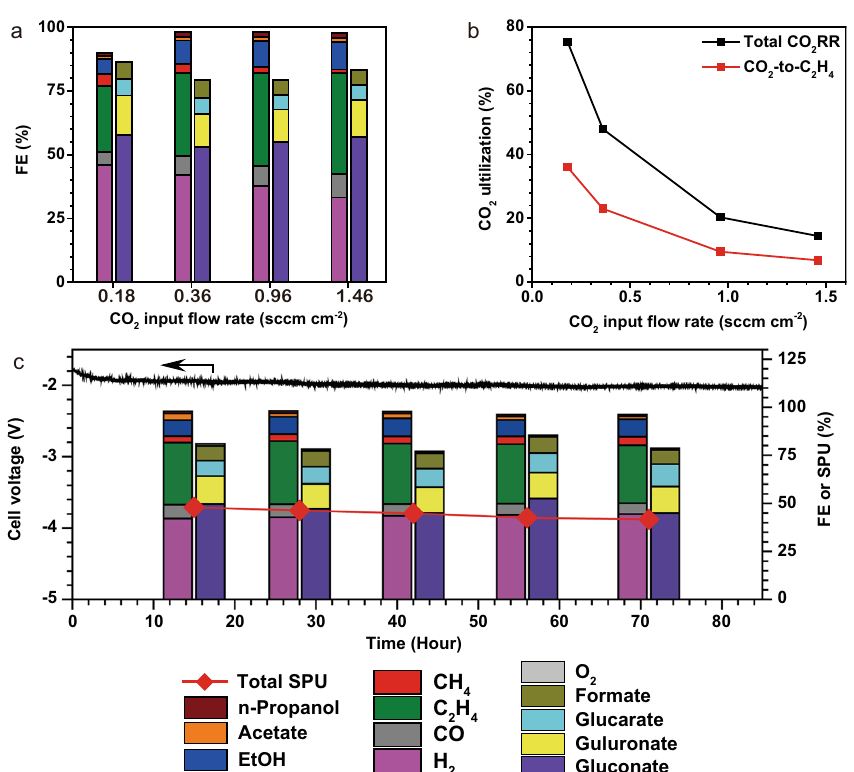
Fig. 4 Performance of the CO 2 RR-GOR system under low CO 2 availability at 50 o C. The mass loadings on the cathode and anode are Cu: 0.5 mg cm − 2 and Pt: 2 mg cm − 2 . a The FE distributions at various CO 2 input fl ow rates. The labels are indicated below ( c ). b The CO 2 carbon ef fi ciency for total CO 2 RR and CO 2 -to-C 2 H 4 (mole ratio of the input CO 2 converted to C 2 H 4 ) at various CO 2 input fl ow rates. c Long-term electrolysis performance with a CO 2 input fl ow rate of 0.36 sccm cm − 2 . The experiments are performed at a current density of 100 mA cm − 2 . The fl ow rate of the CO geometric area of the